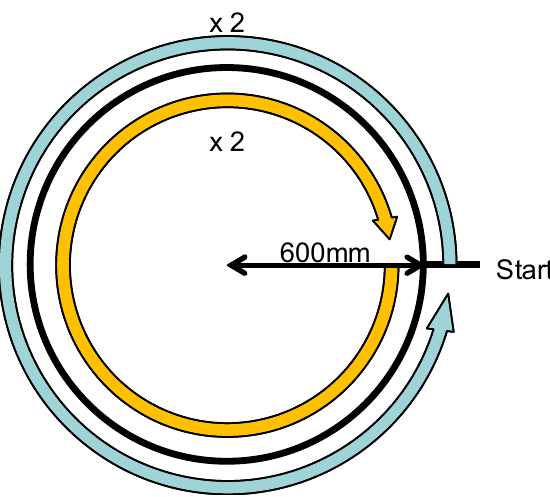
Figure 15. Programmed path for ballbar test.